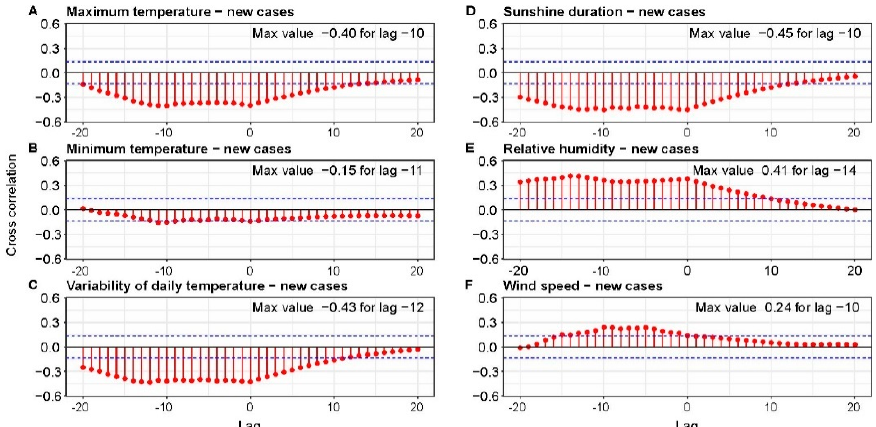
Figure 5. Cross-correlation between number of new cases and meteorology parameters: maximum daily temperature ( A ), minimum daily temperature ( B ), variability of daily temperature ( C ), sunshine duration ( D ), relative humidity ( E ), wind speed ( F ). The 95% confidence bounds are plotted in